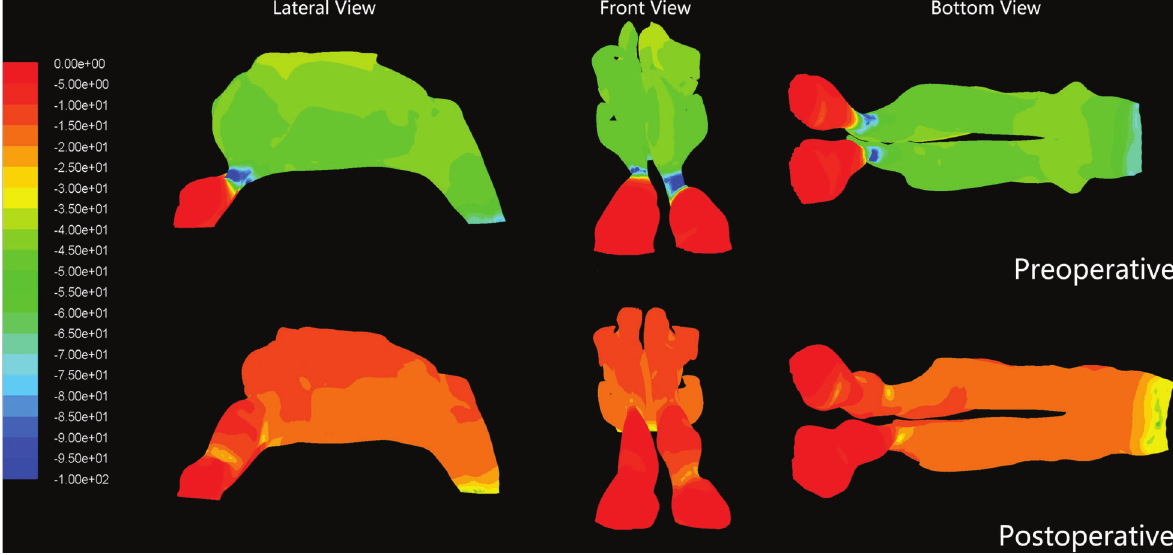
Figure 3. Pre- and postoperative air fl ow pressure distribution of the nasal cavity in one patient with anterior nasal cavity stenosis. Comparison of pre- and postoperative pressure distribution revealed that the pressure gradually decreased from the anterior nostril to the nasopharynx. Red color indicates higher